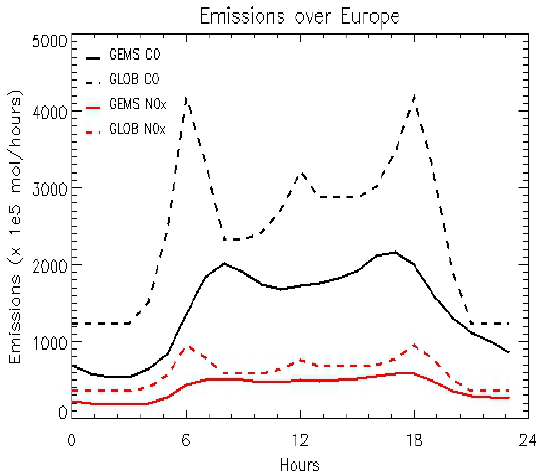
Fig. 2. Diurnal cycle of CO (black line) and ozone (red line) total emissions over Europe for the GEMS-TNO emission inventory (solid line) and for the global emission inventory (dashed line) for the July 6 th , 2009.